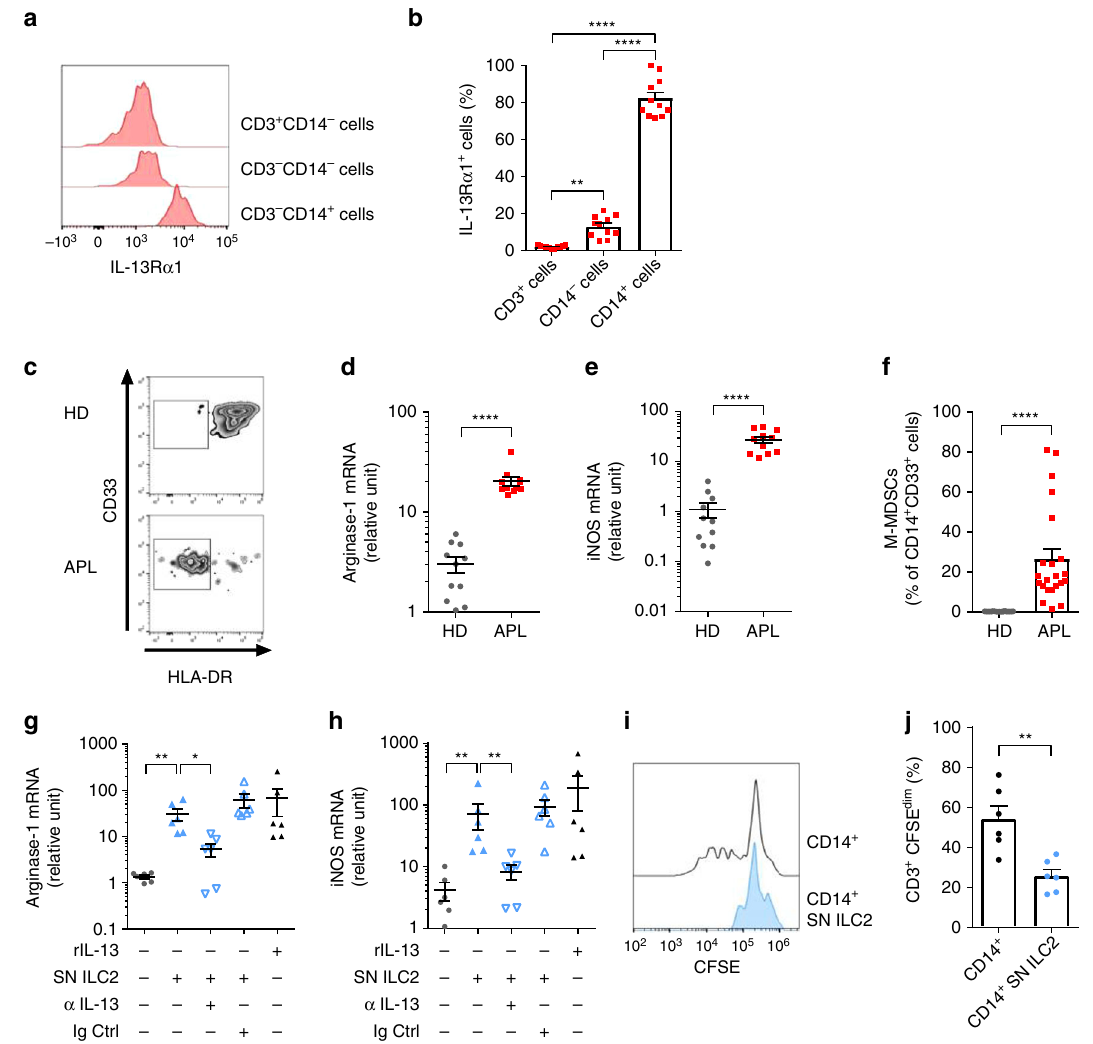
Fig. 3 ILC2-derived IL-13 expands and activates suppressive M-MDSCs in APL. a Representative example of fl ow cytometry analysis of cell surface expression of the IL-13R α 1 on CD3 + , CD14 − , CD14 + cells in peripheral blood of an APL patient. b Frequencies of IL-13R α 1 expressing cells in the different compartments (CD3 + , CD14 − , CD14 + n = 11). c Representative example of fl ow cytometry phenotypic analysis of CD14 + cells in healthy donors (HD) and APL patients (APL). Evaluated are the expression of HLA-DR and CD33, to de fi ne phenotypic M-MDSC. d Expression of arginase-1 and e iNOS in puri fi ed CD14 + cells from HD and APL, as assessed by qPCR ( n = 11). f Frequency of M-MDSCs in peripheral blood of HD and APL ( n = 22). g , h Expression of arginase-1 ( g ) and iNOS ( h ) as assessed by qPCR, in puri fi ed CD14 + cells cultured in medium supplemented or not with recombinant IL-13 (rIL-13), or cultured in supernatants derived from ILC2 cell lines, activated by PDG2 and the NB4 APL cell line (SN ILC2). A blocking anti-IL-13 antibody (aIL-13) or an Ig control (Ig Ctrl) were added where indicated ( n = 6, three independent experiments). i Representative example of CFSE-dilutions of CD3 + T cells co-cultured with CD14 + monocytes, or with in vitro - induced M-MDSCs (CD14 + SN ILC2). j Frequencies of proliferating CD3 + T cells upon co-culture with CD14 + cells or with in vitro induced M-MDSCs (CD14 + SN ILC2) ( n = 6, three independent experiments). Error bars are s.e.m. Statistical analysis was performed using ANOVA test ( b ), t test ( d – f ), Kruskal-Wallis test ( g , h ) and Mann-Whitney test ( j